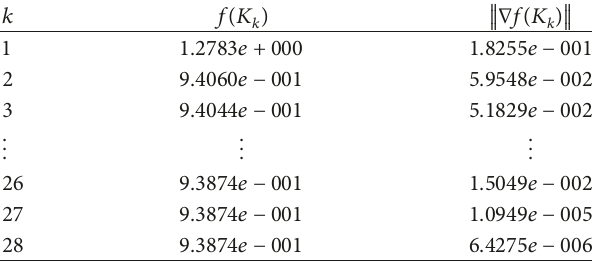
Table 1: Convergence behavior of the CG method to a local solution for Example